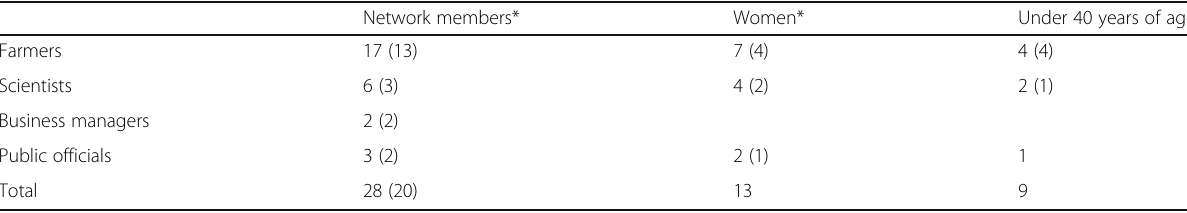
Table 1 Network members by category, gender and age